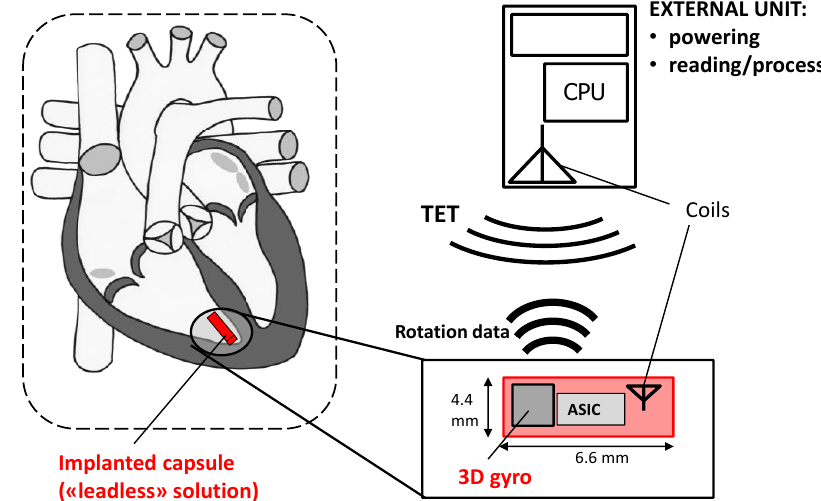
Figure 7. Scheme of a possible leadless CardioMon solution designed as a stand-alone implantable cardiac monitor.